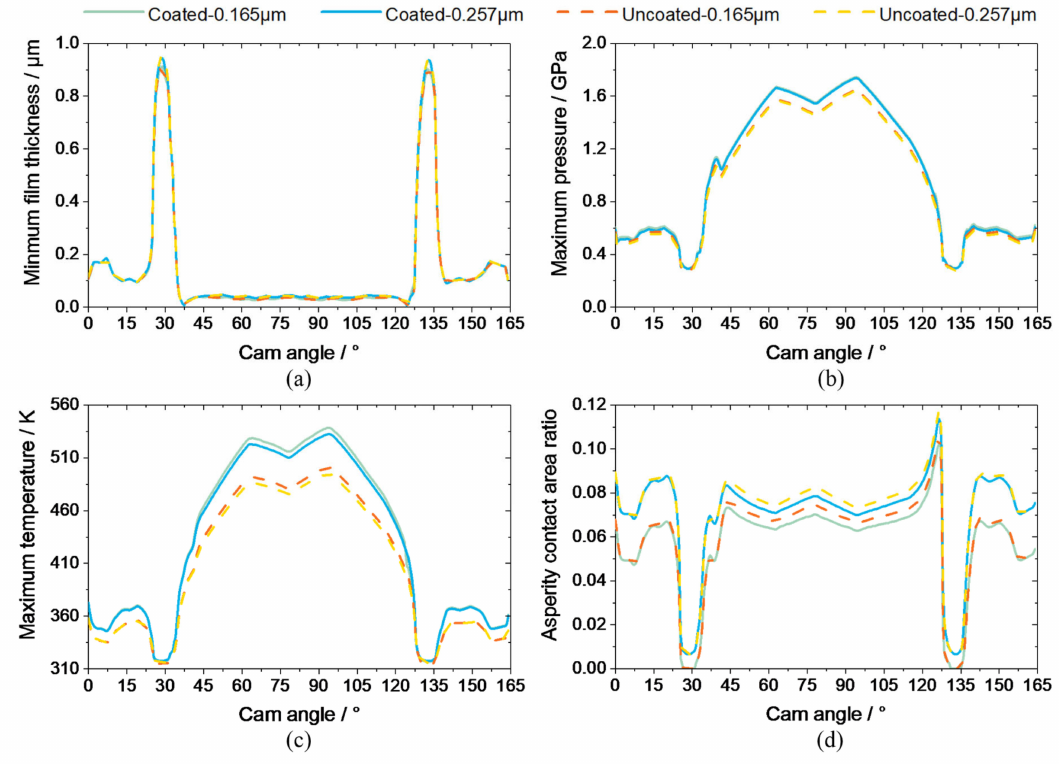
Figure 11. Variations of the lubrication state during a cam cycle under the heavy load: ( a ) the minimum film thickness, ( b ) the maximum film pressure, ( c ) the maximum temperature of the lubricant, and ( d ) the asperity contact area